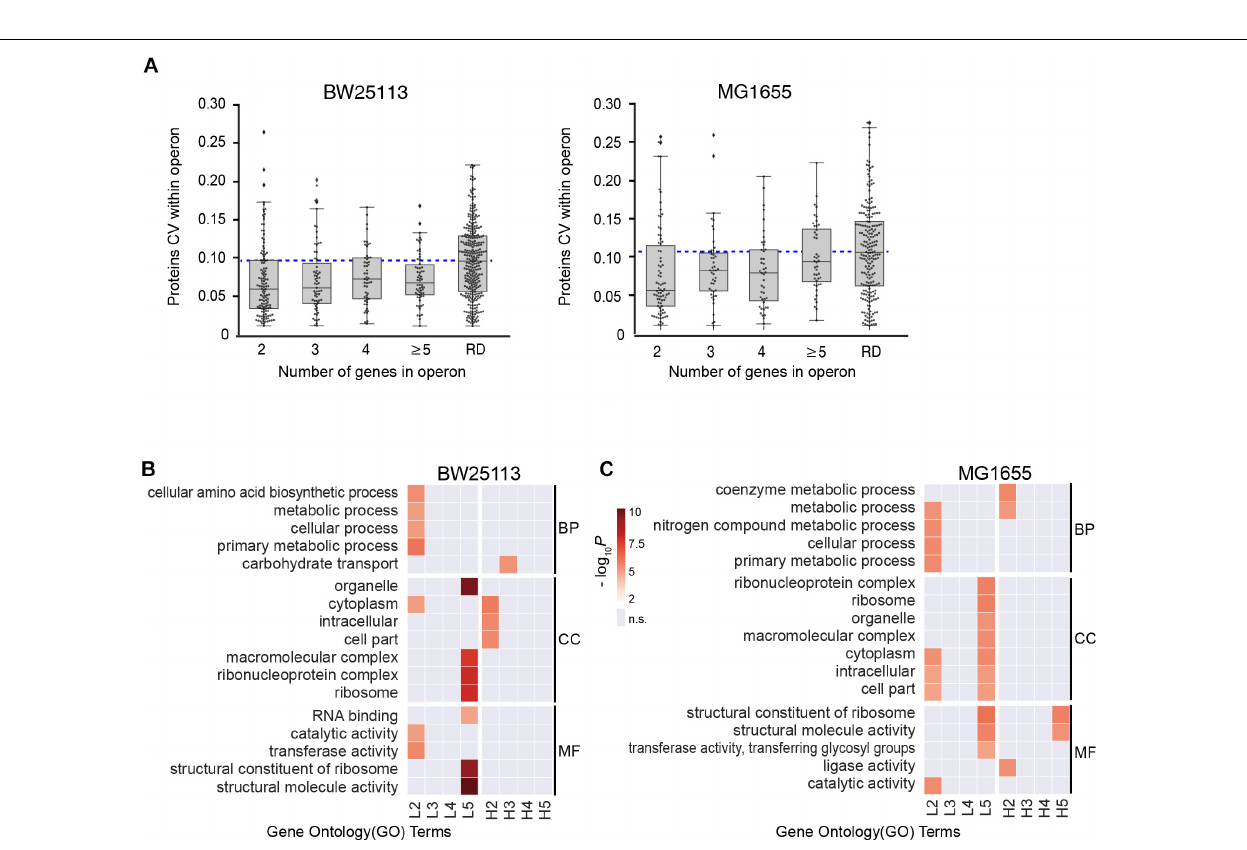
Frontiers in Genetics |